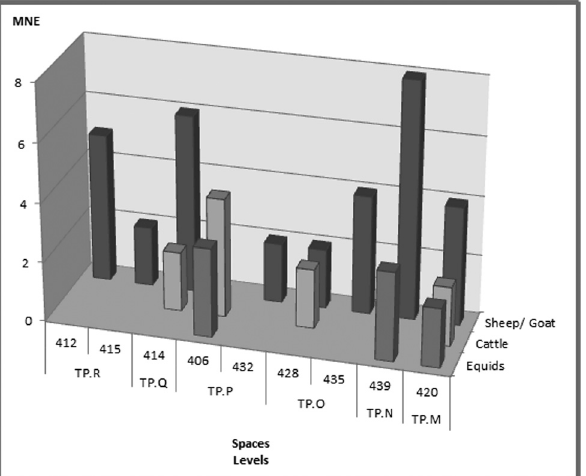
Figure 5: Çatalhöyük East, TP middens. Bar chart showing the frequency of articulated bones of sheep/goat, cattle, and equids through TP levels and the spaces within them MNE: minimum number of